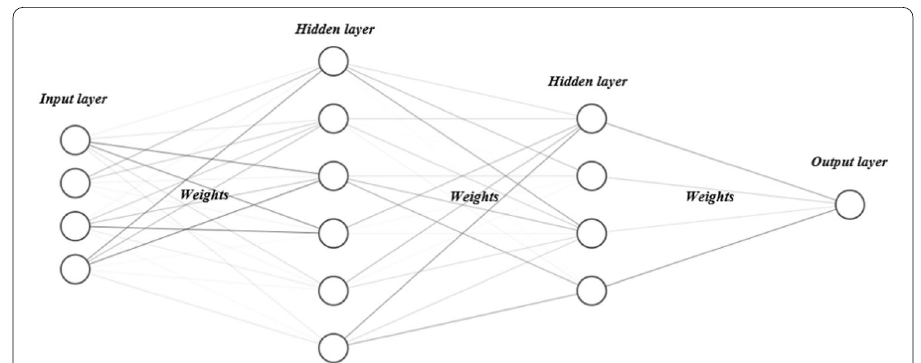
Fig. 1 Deep neural network with two hidden layers [24]